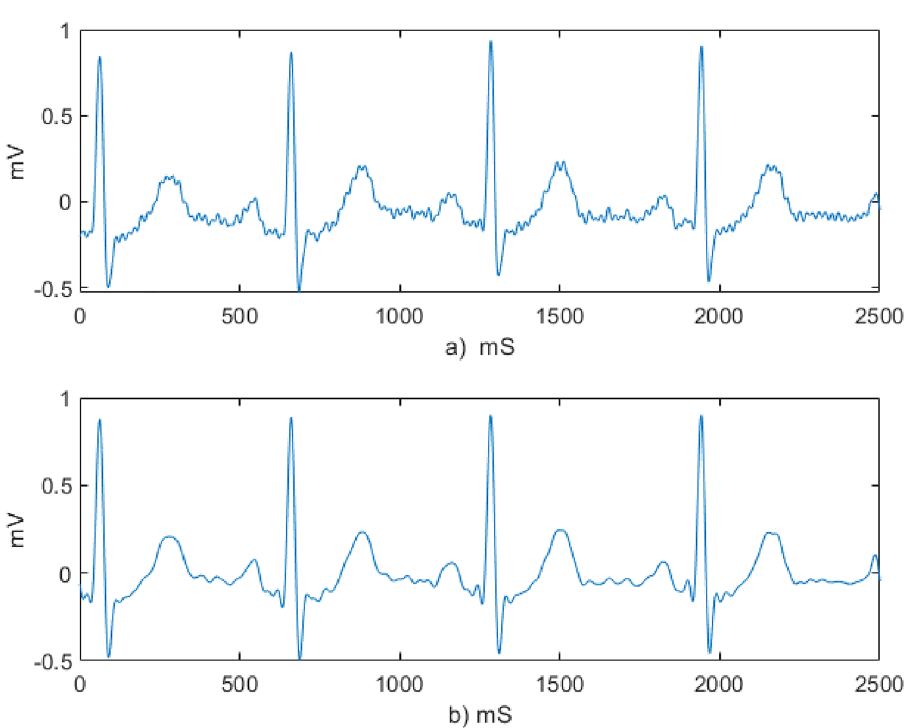
Figure 5. ECG signal denoising using Wavelet transform ( a ) input signal to wavelet multiresolution analysis ( b ) output signal of wavelet multiresolution